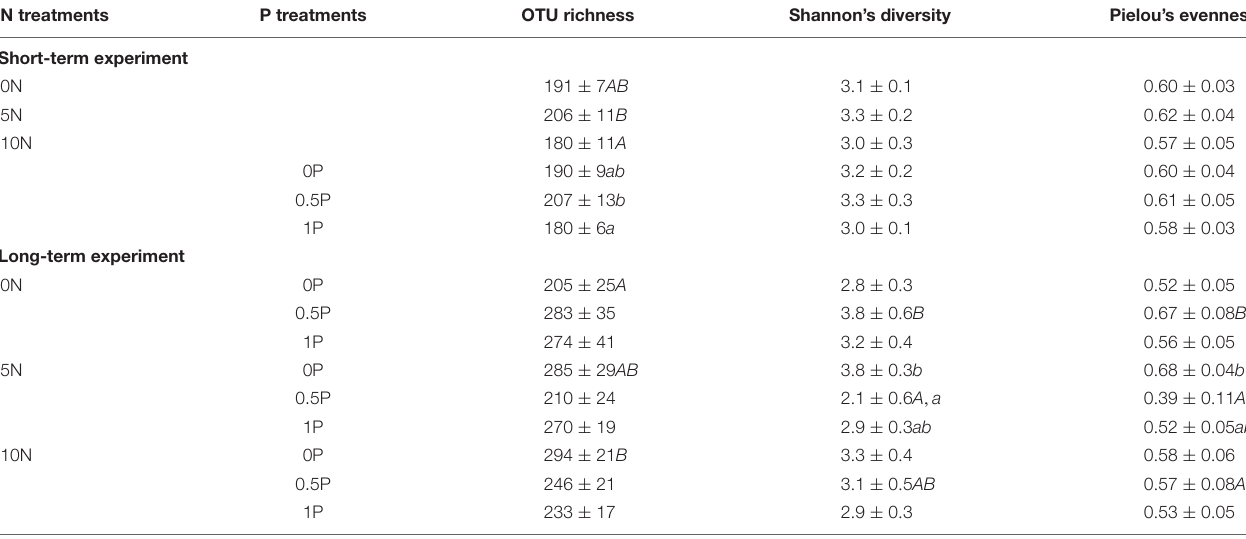
TABLE 2 | Alpha-diversity indices (mean ± SE, n = 4) under different N and/or P fertilization treatments for short- and long-term experiments. N treatments P treatments OTU richness Shannon’s diversity Pielou’s evenness